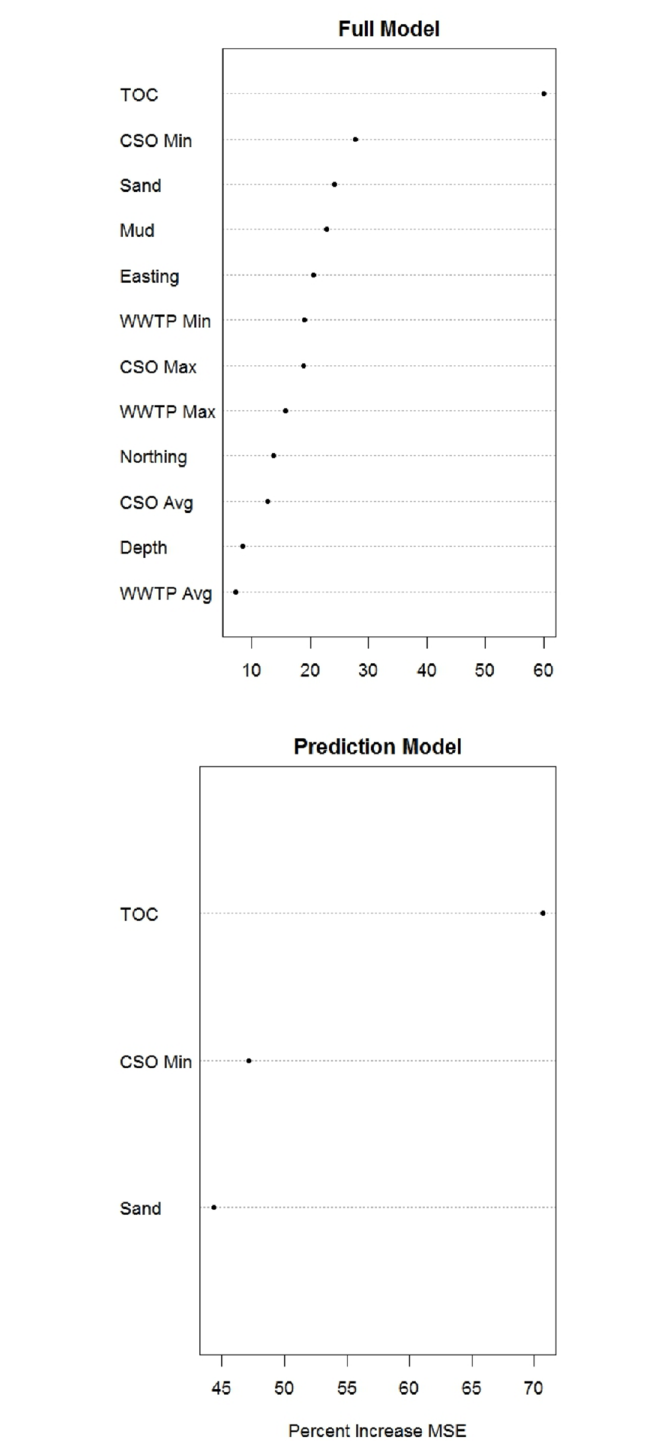
Fig 2. Random Forest variable importance ranks for the full and prediction model, which the latter was used to predict triclosan contamination in Narragansett Bay, Rhode Island. Percent increasein MSE (mean squarederror) is a measureof variableimportance; the closer to zero the less important the variableis for predicting.CSO, combinedsewer overflow;Mud, sand/silt composition; Northing and Easting, geographiccoordinates; TOC, total organic carbon; WWTP, wastewater treatment plant.